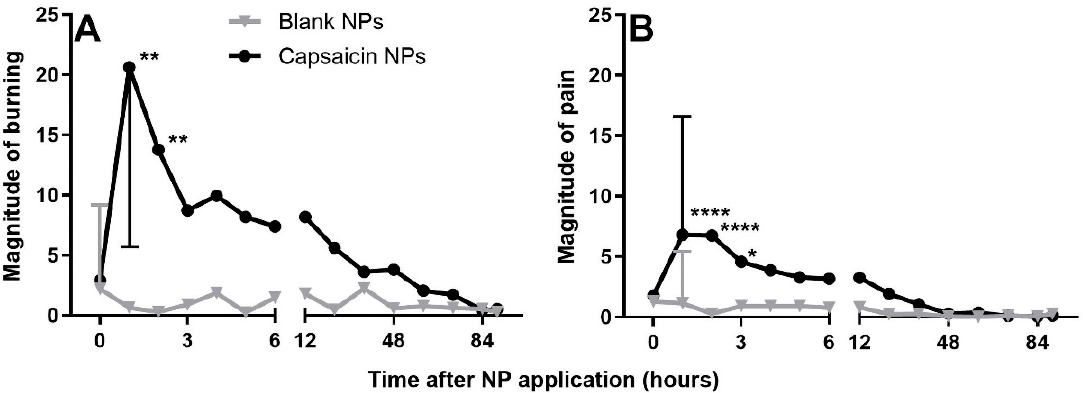
Figure 4. Magnitude ratings of spontaneous (background) sensations of burning and pain referred to the sites of application of blank and capsaicin filled NPs. ( A ) Magnitude of burning, ( B ) magnitude of pain. Mean ± SD, n = 21, mixed effect model 2 within subject treatments (capsaicin vs. placebo treatment) × 14 repeated timepoints (0–90 h) with Bonferroni correction. * p < 0.05, ** p < 0.01, **** p < 0.0001 for blank vs. NP comparison.